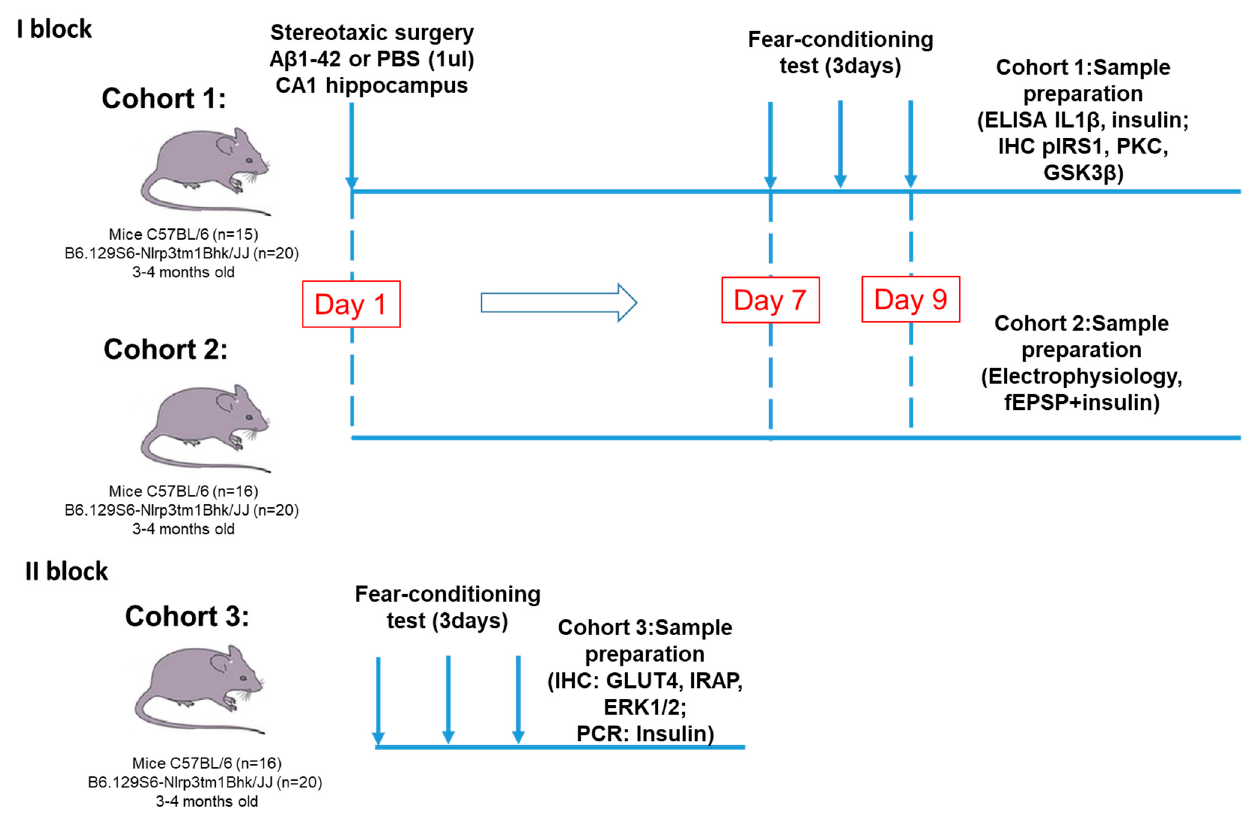
Figure 11. Experimental design. The study consisted of two main blocks. The first one was devoted to the investigation of the NLRP3 role in synaptic transmission, memory formation, glucose metabolism and insulin signaling in modeling A β -induced neurodegeneration. In the first block two cohorts of mice were used for immunohistochemistry and ELISA and for electrophysiological assessment. In the second block we evaluated the NLRP3 expression effect in the brain tissue on insulin-regulated transport of the glucose transporter. PBS—phosphate-saline buffer, A β —beta-amyloid, IHC—immunohistochemistry, PCR—polymerase chain reaction.